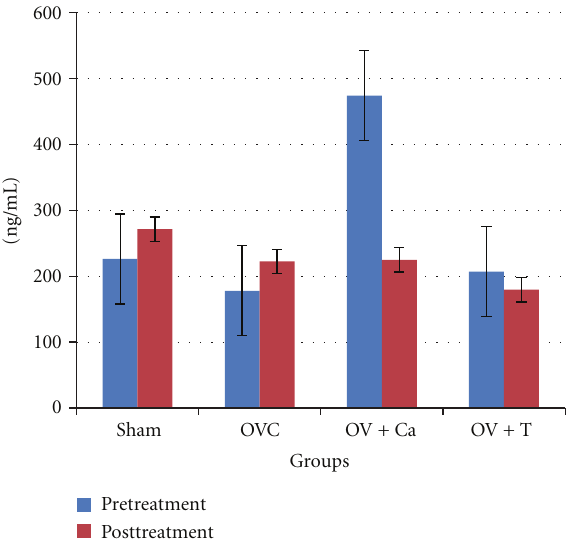
Figure 7: Serum osteocalcin. Sham: sham-operated rats given deionised water and vehicle olive oil. OVC: ovariectomised rats given deionised water and vehicle olive oil. Ov+Ca: ovariectomised rats given 1% calcium in deionised water and vehicle olive oil. Ov+T: ovariectomised rats given deionised water and palm tocotrienol. No significant di ff erence was seen between the groups at P < 0 .